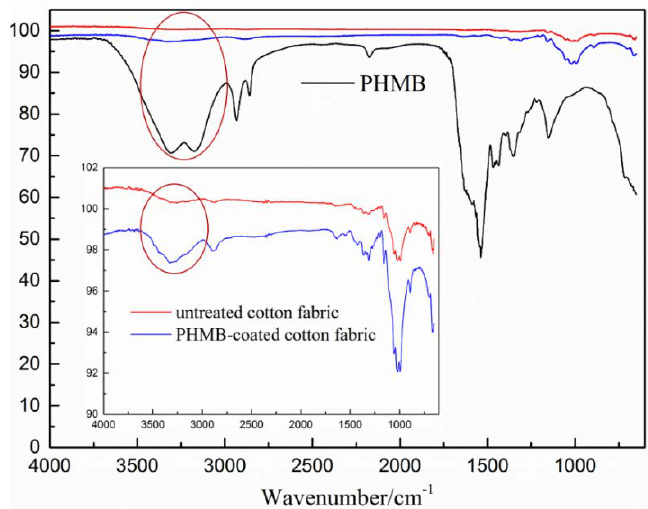
Figure 3. FTIR absorbance spectra of PHMB, untreated cotton fabric and PHMB-coated cotton fabric. The insert shows the spectrum of untreated cotton and treated counterpart.